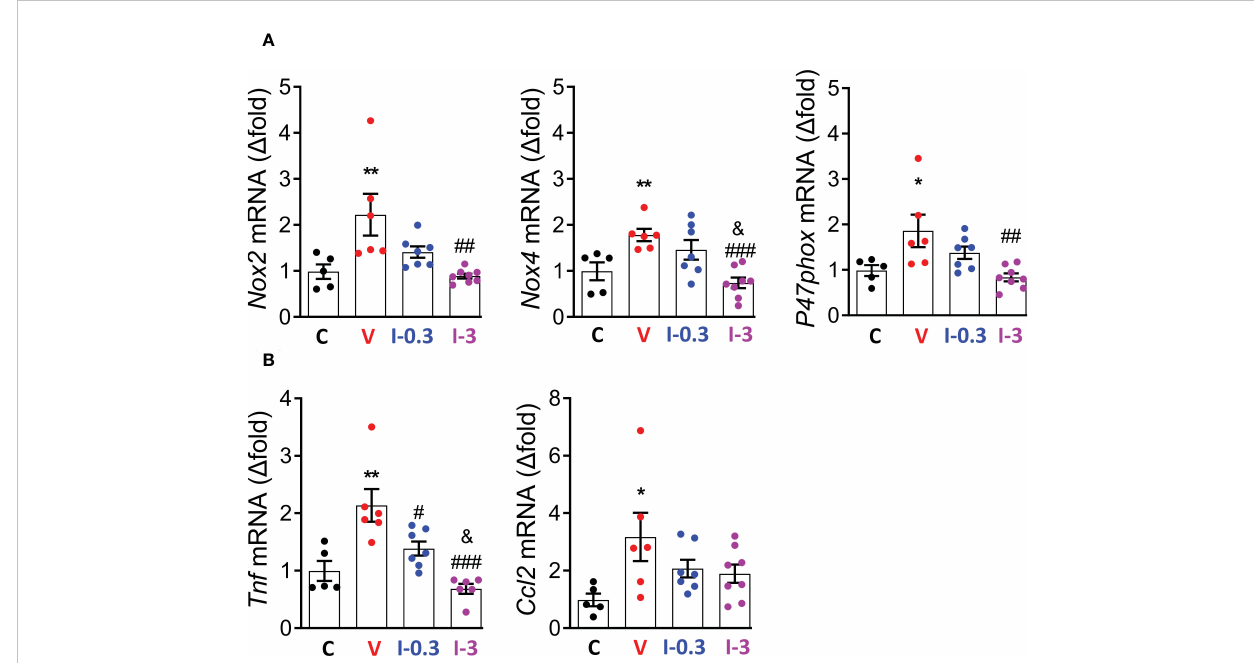
FIGURE 7 INV-202 reduces both renal oxidative stress and in fl ammatory markers. (A) mRNA analysis of Nox2 , Nox4 , and P47phox coding for NADPH oxidative isoforms (GP91Phox, NADPH oxidative 4, and neutrophil cytosol factor 1, respectively). (B) mRNA analysis of Tnf and Ccl2 coding for TNF and C-C motif chemokine ligand 2. Statistical signi fi cance versus nondiabetic control: *p < 0.05; **p < 0.01; versus vehicle: #p < 0.05; ##p < 0.01; ###p < 0.001; versus INV-202 group, 0.3 mg/kg: &p < 0.05. NADPH, nicotinamide adenine dinucleotide phosphate; TNF, tumor necrosis factor. C: non-diabetic control mice, V: Vehicle-treated diabetic mice, I-0.3: INV-202-treated diabetic mice (0.3 mg/kg), I-3: INV-202-treated diabetic mice (3